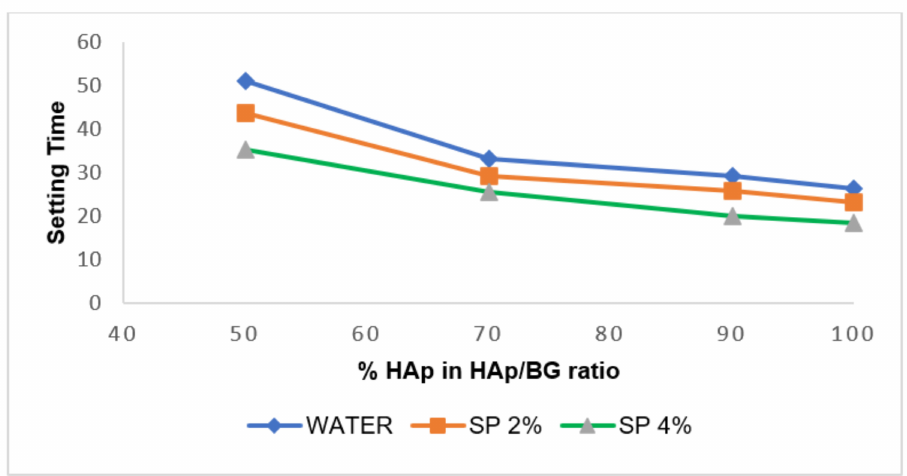
Figure 5. Effect of liquid phase on setting time by HAp percentage in HAp/BG cements (mean ± SD, n = 3, p ≤